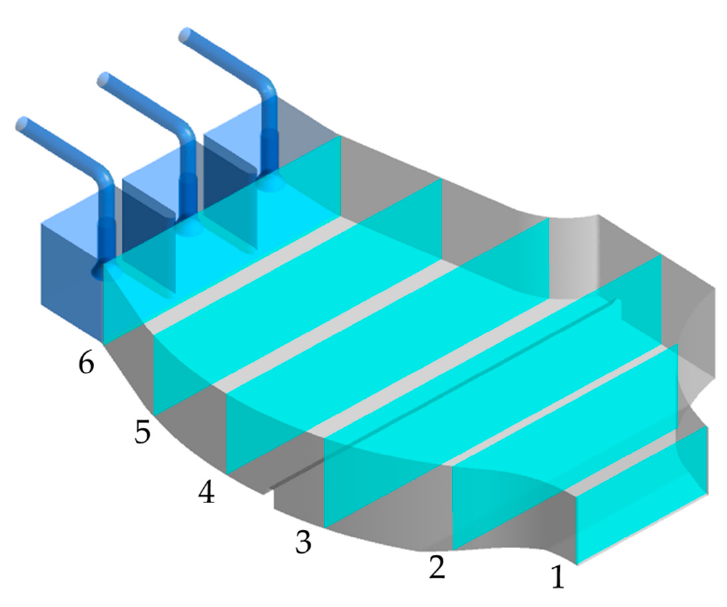
Figure 18. Schematic diagram of a characteristic section of the forebay.